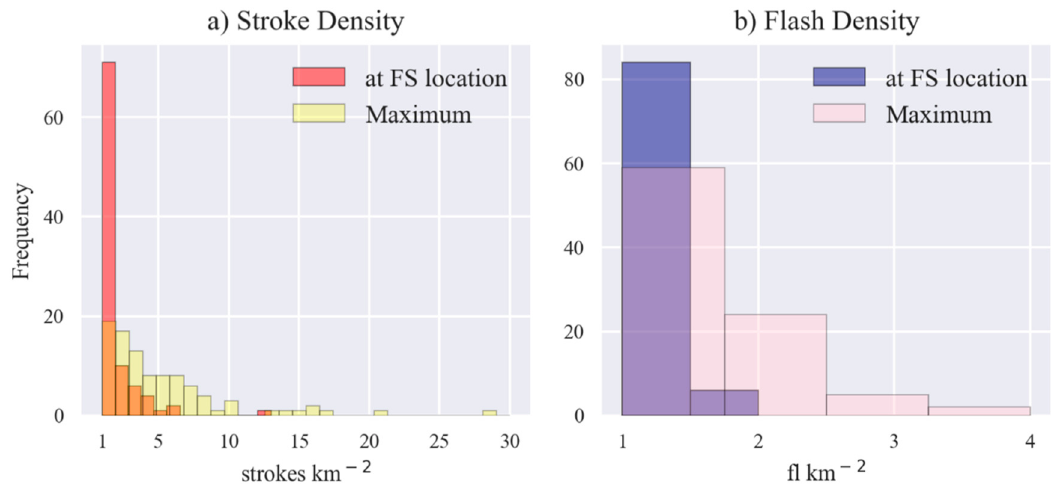
Figure 3. Frequency of ( a ) stroke density at the FS flash location and maximum stroke density, ( b ) mean flash density (rounded to the nearest tenth) at the FS flash location and maximum flash density.